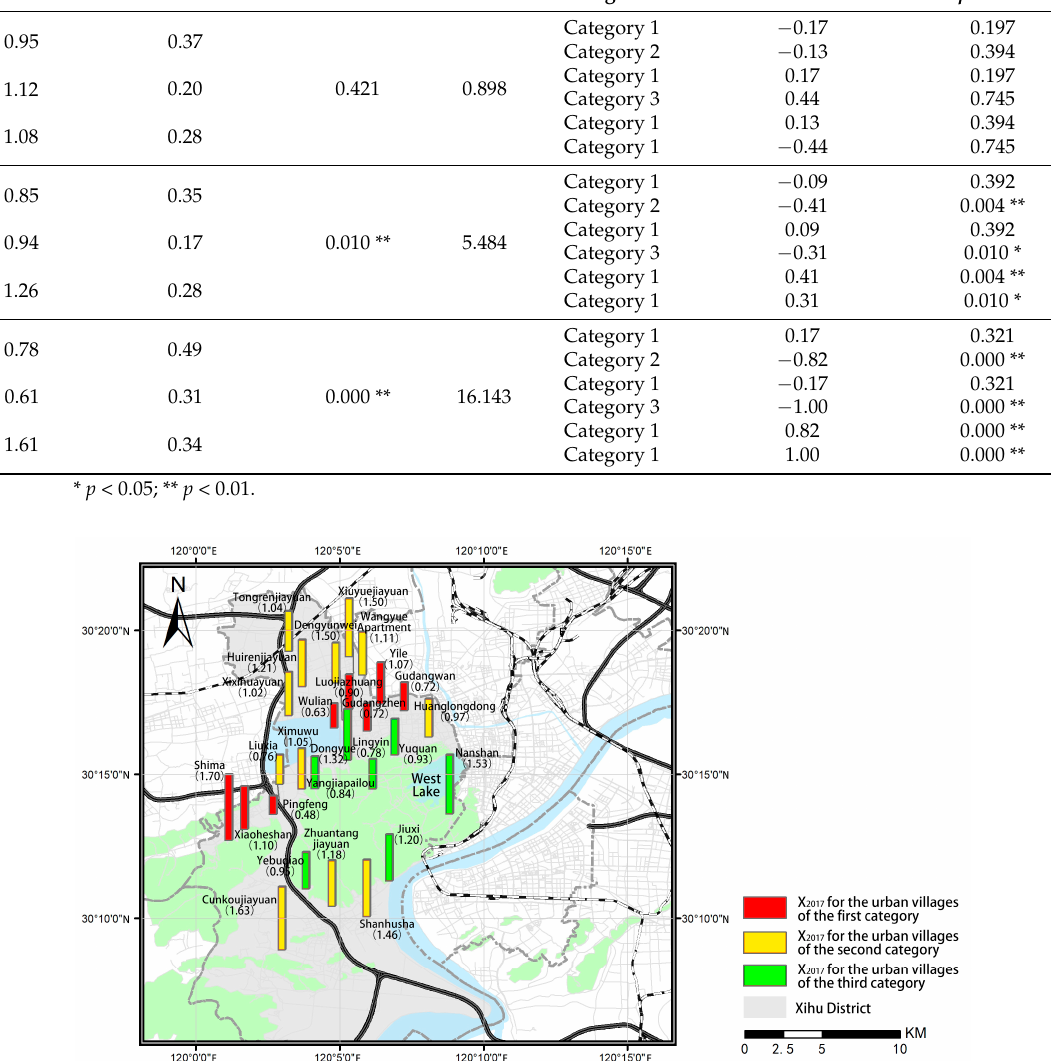
Table 3. Comparison of the housing rent in the three types of urban villages through ANOVA.